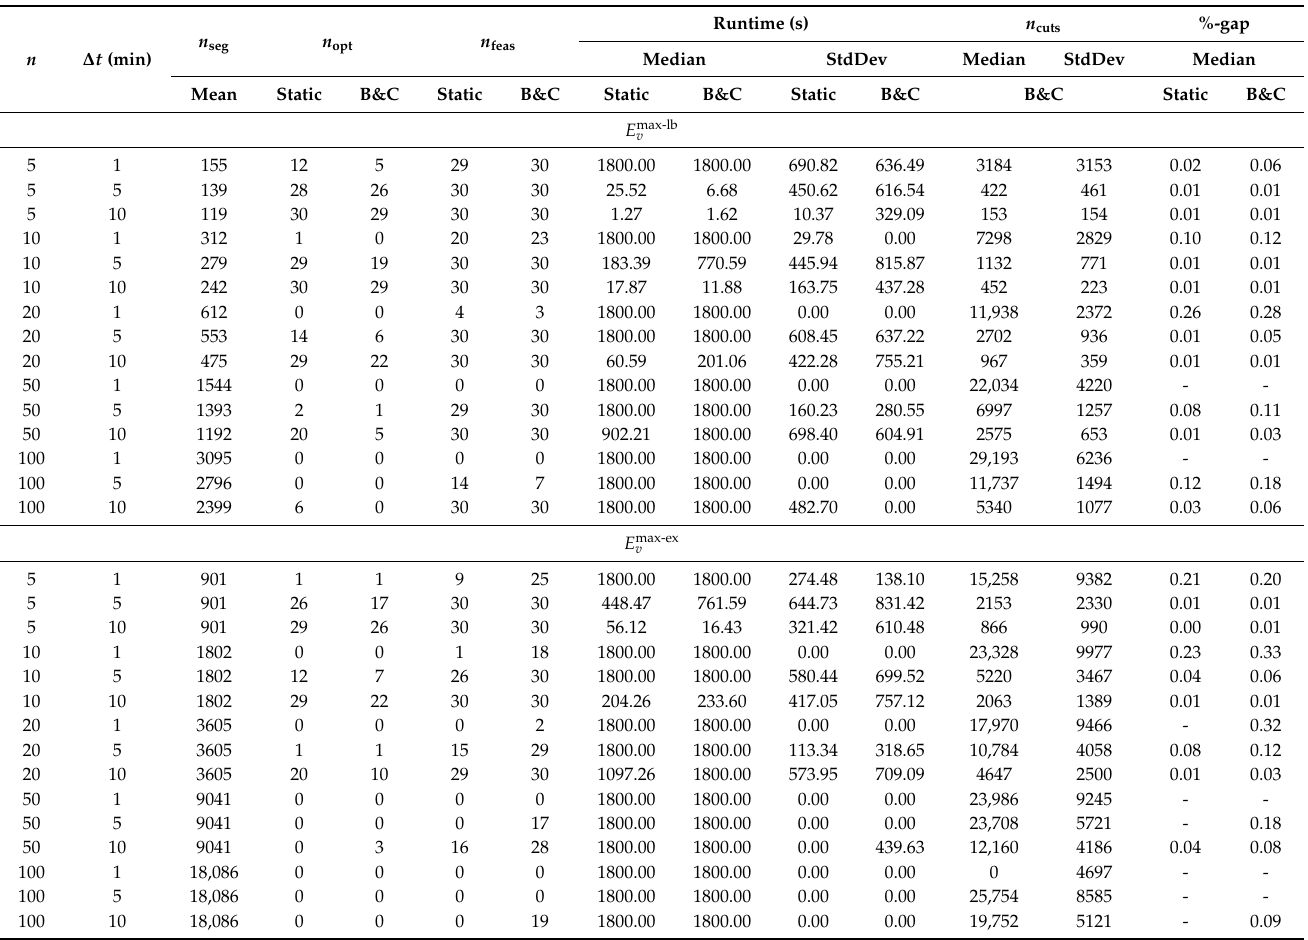
Table A2. EVS-SOC-GLIN results for solving the static model versus B&C with E max-lb v and E max-ex v based on the original P max v functions and P gridmax = 25 n .